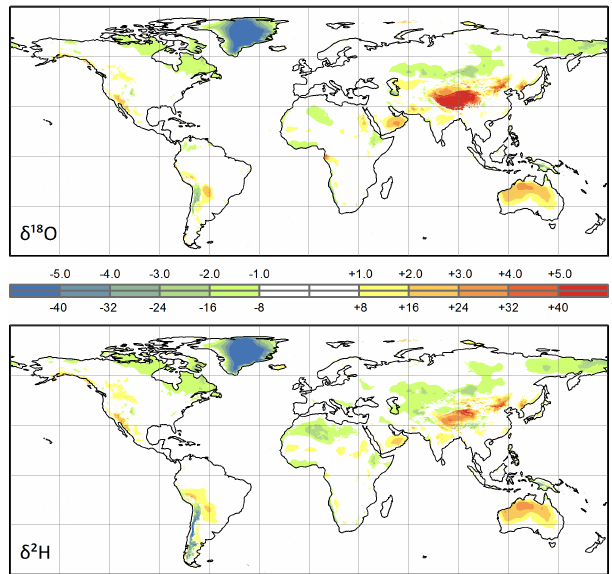
Fig. 13. Comparison of difference ( ∆ δ = δ M4 − δ M1 ) in predicted amount weighted δ 18 O ANN (upper panel, scale) and δ 2 H ANN (lower panel, scale) comparing Model M1 and M4. The isotopic scale bar and color scheme indicate the extent, positive or negative, and locations where M4 produced more positive or negative predicted values than M1.